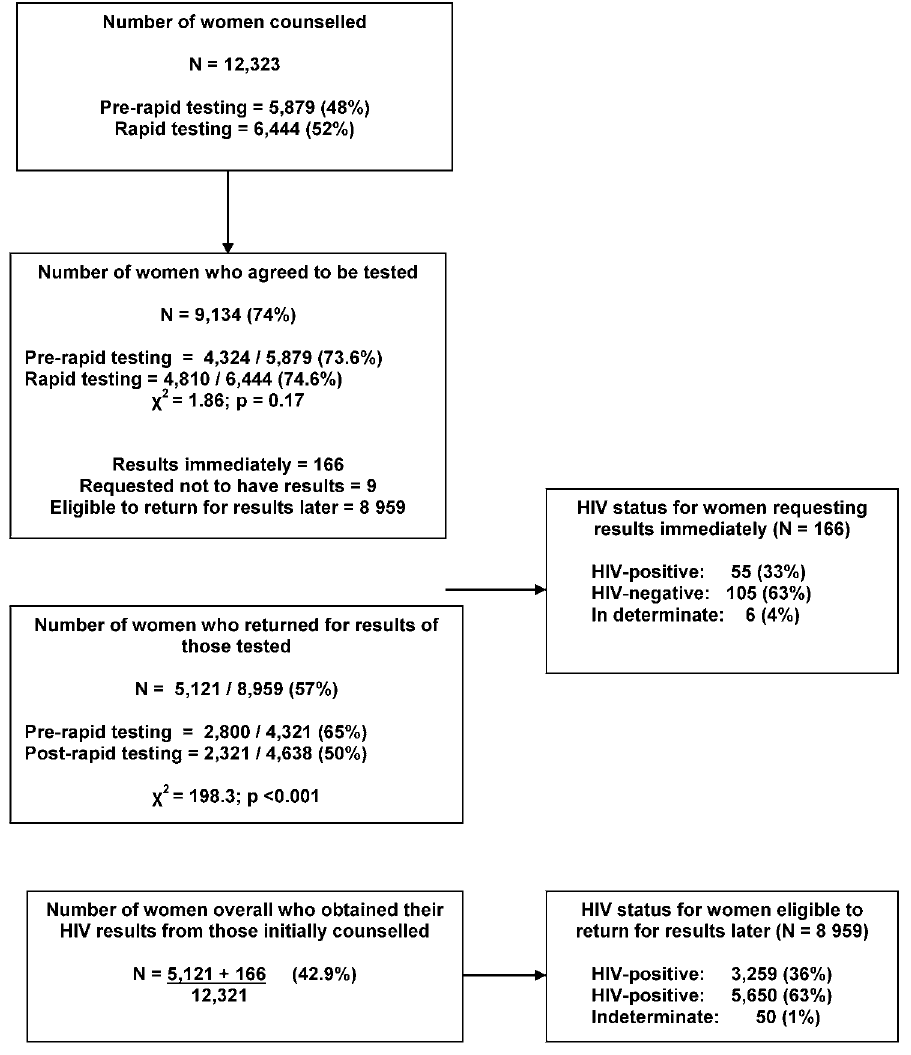
Figure 1. Proportion of women accepting HIV counselling and their HIV results.